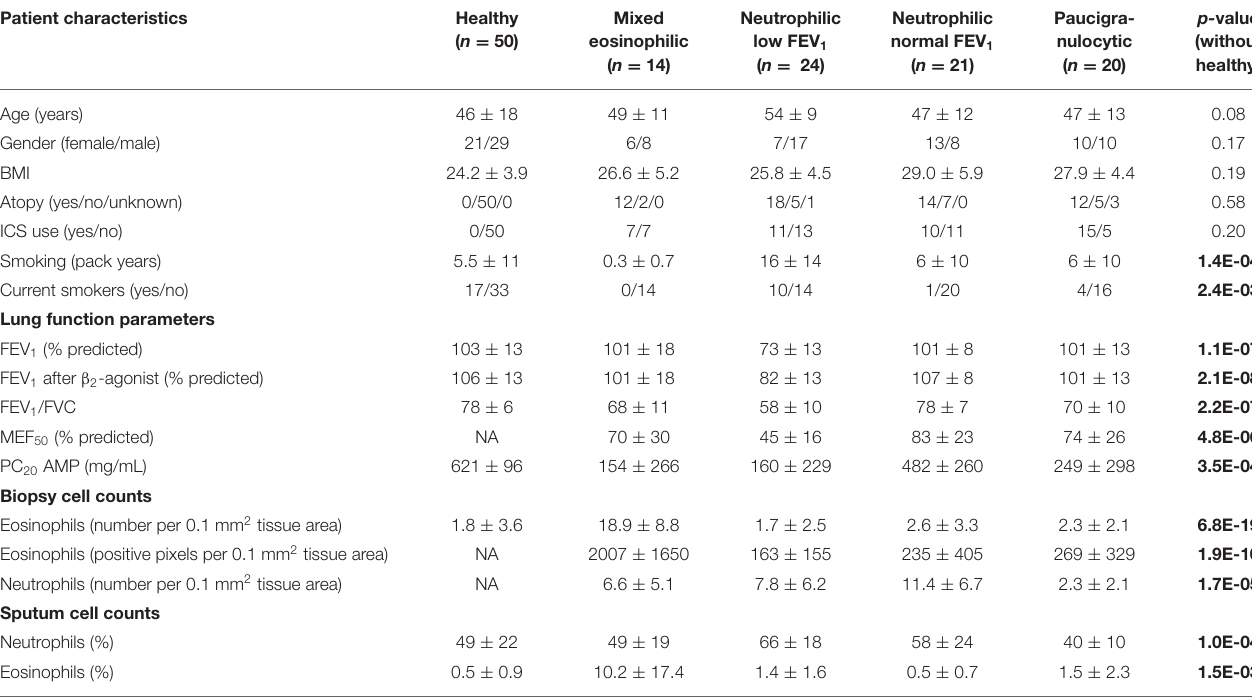
TABLE 1 | Characteristics of patients in the different asthma subgroups and healthy controls (added for comparison). Patient